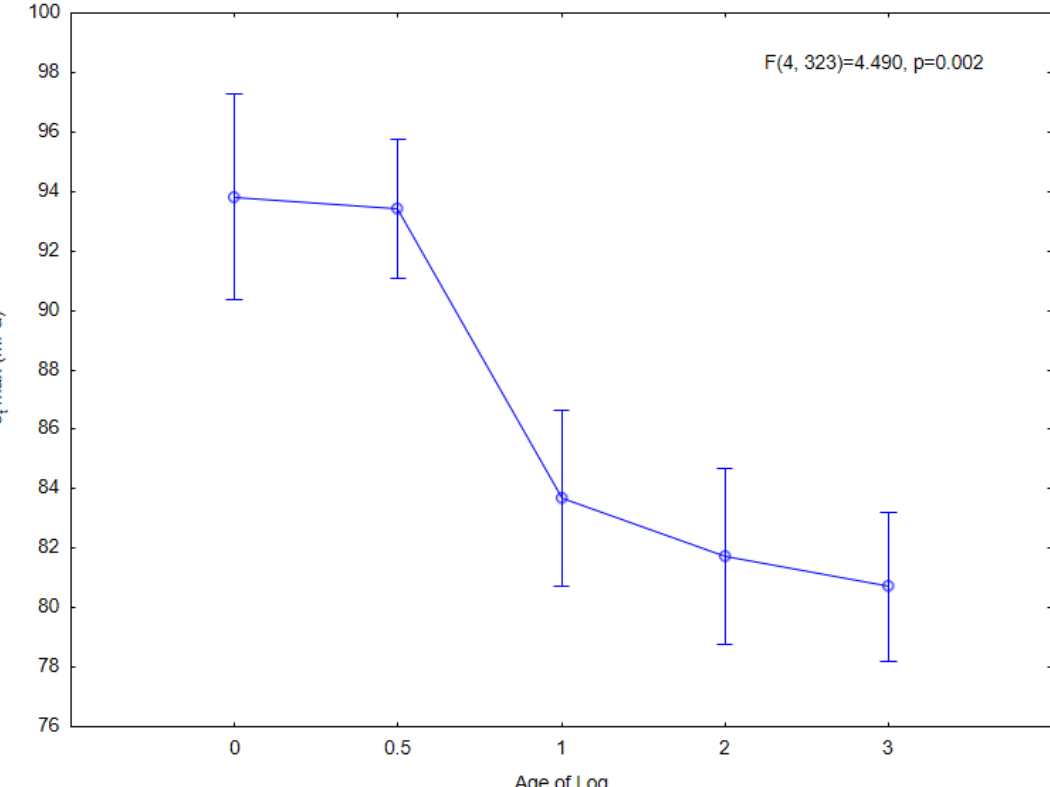
Figure 4. S tatistical evaluation of the effect of log age on tensile strength using ANOVA . Figure 4. Statistical evaluation of the effect of log age on tensile strength using